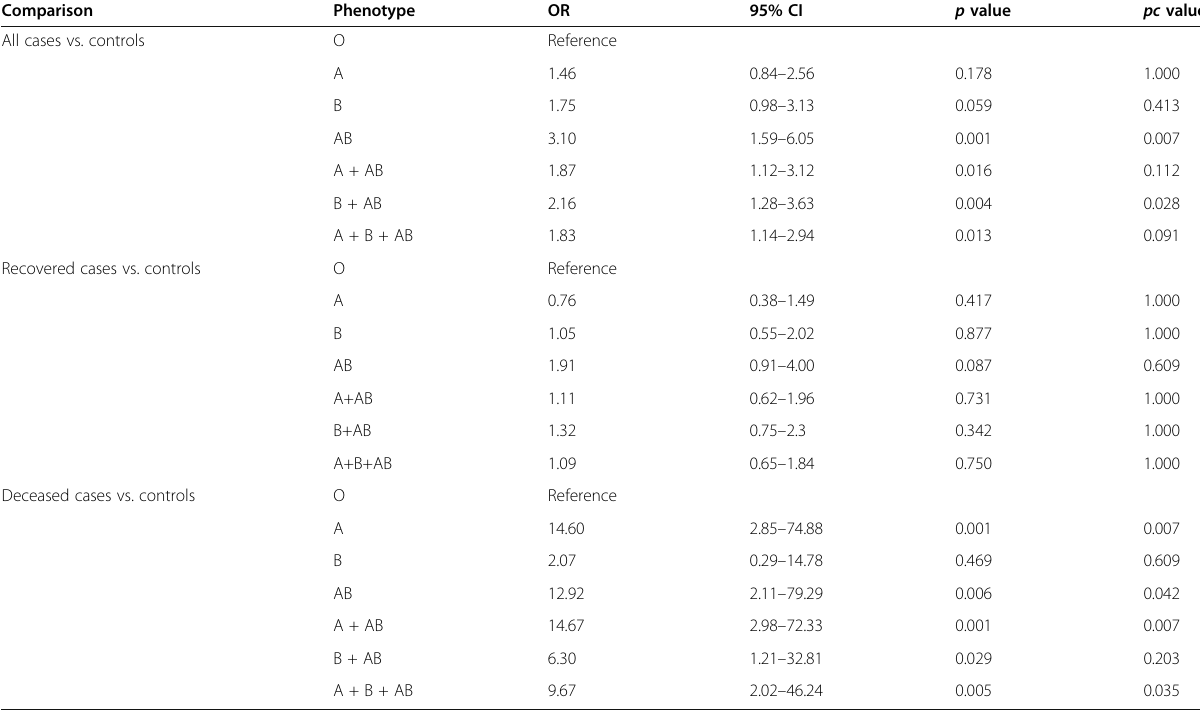
Table 4 Genetic association of ABO blood group phenotypes with coronavirus disease 2019